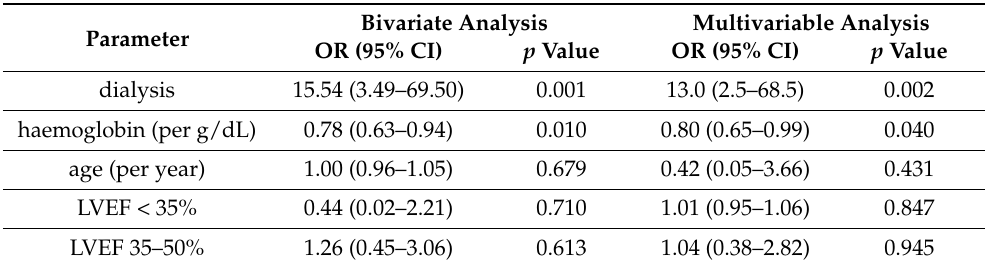
Table 3. Multivariate logistic regression analysis with the endpoint as major periprocedural com- plications.